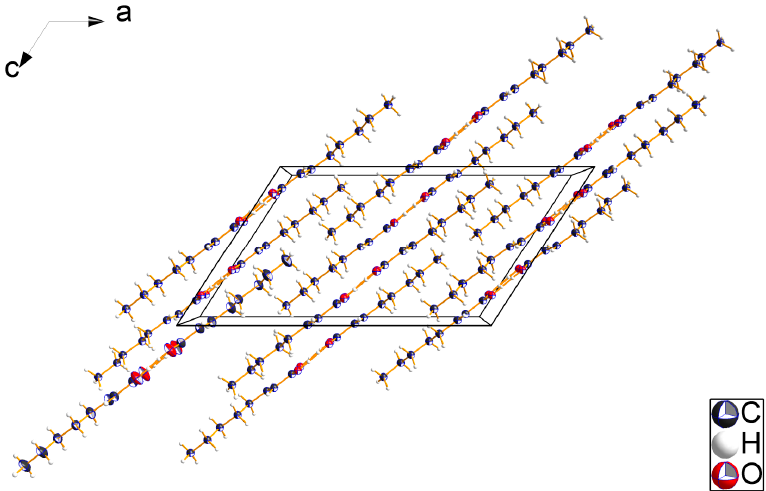
Figure 5. View of the packing of acid dimer molecules in the crystal of C8 along the crystallographic b axis.